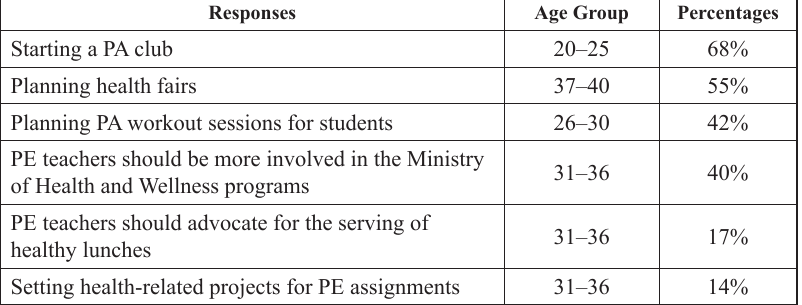
Table 4. The perceived strategies to Responses Age Group Percentages promote PA and a healthy lifestyle in Starting a PA club 20–25 68% schools Planning health fairs 37–40 55% Planning PA workout sessions for students 26–30 42% PE teachers should be more involved in the Ministry 31–36 40% of Health and Wellness programs 31–36 17% healthy lunches 31–36